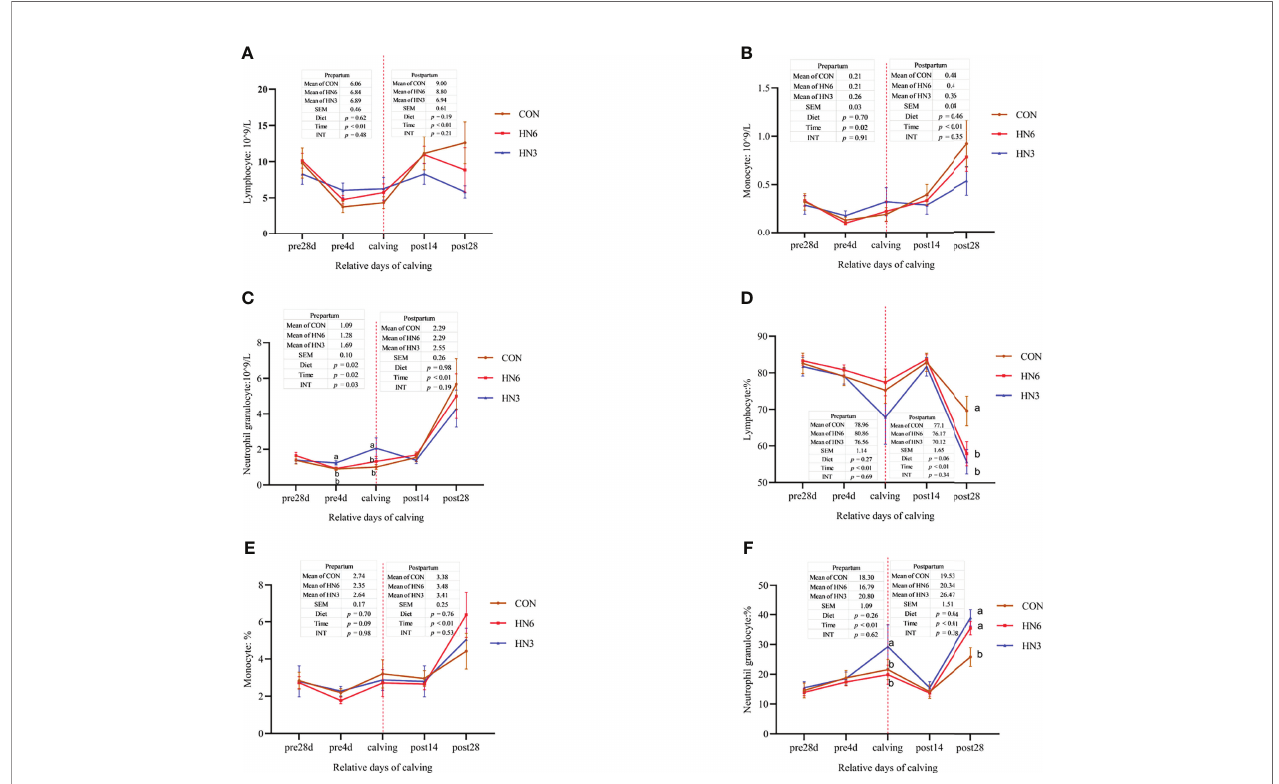
FIGURE 1 | Blood immune cell counts in maternal cows. CON: control treatment (saturated fatty acid source), n = 12. HN3: extruded fl axseed treatment (n-3 PUFA source), n = 12. HN6: extruded soybean treatment (n-6 PUFA source), n = 13. SEM, standard error of the mean; Diet, diet treatment effect; Time, the calving time effect; INT, the interaction effect between diet effect and time effect. Values in the same sampling time point denoted by different superscript lowercase letters indicate signi fi cant differences ( p < 0.05) between treatments, whereas those denoted by the same letters or no letters are not signi fi cantly different ( p > 0.05). (A – C) : the blood immune cell counts in maternal cows; (D – F) : the percentage of blood immune cell in maternal